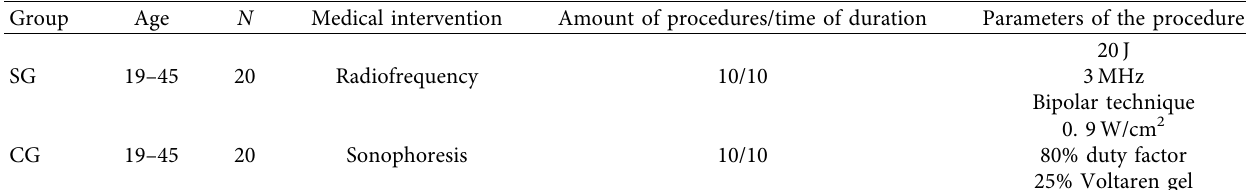
Table 3: The radiofrequency parameters used in the treatment of the patients in groups SG and CG. Group Age N Medical intervention Amount of procedures/time of duration Parameters of the